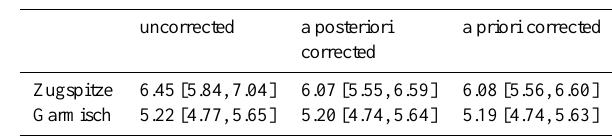
Table 1. XCH 4 trend (ppbyr − 1 ) for the April 2006–March 2015 time interval and corresponding 95% confidence intervals; Zugspitze and Garmisch sites, uncorrected, a posteriori and a pri- ori